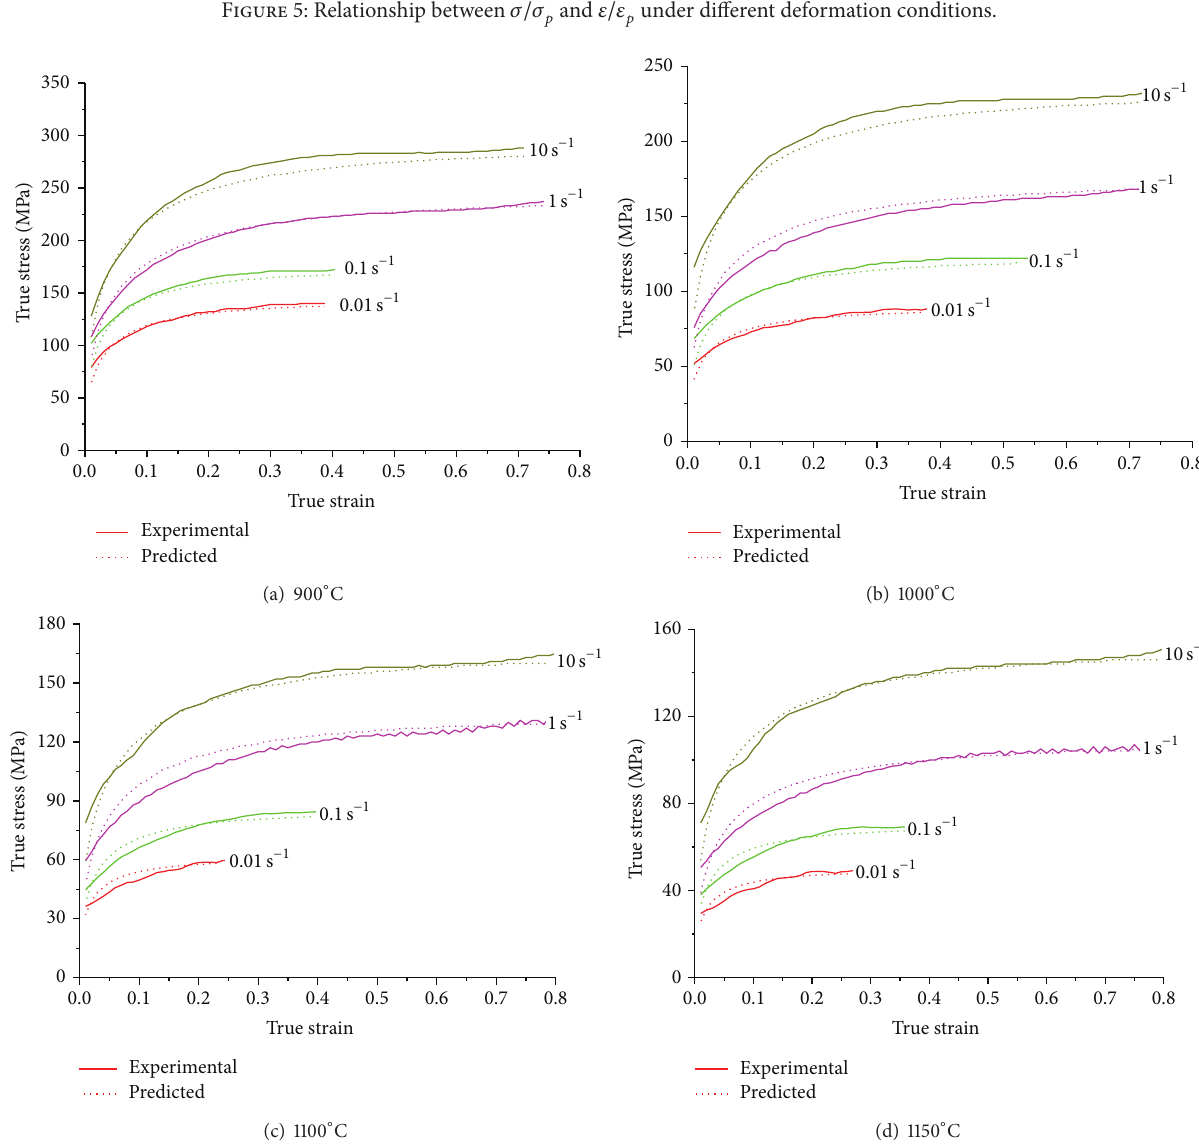
Figure 6: Comparison of the predicted value by the model with the experimental